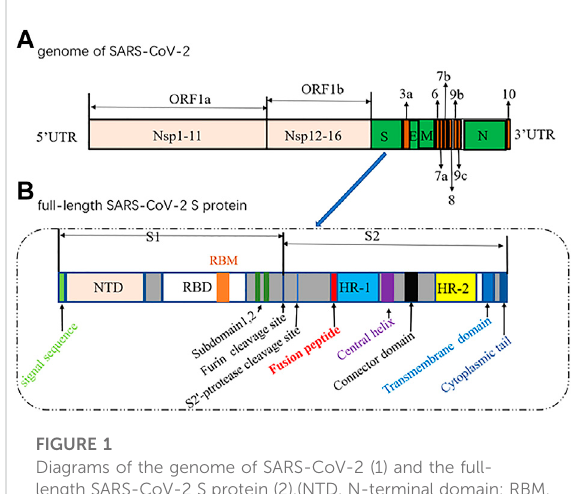
FIGURE 1 Diagrams of the genome of SARS-CoV-2 (1) and the full- length SARS-CoV-2 S protein (2).(NTD, N-terminal domain; RBM, receptor-binding motif; RBD, receptor-binding domain; HR, heptad